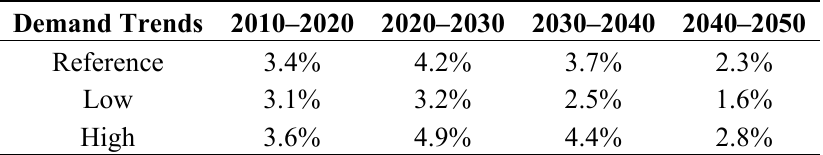
Table 7. Growth rates for commercial energy demand in scenarios.